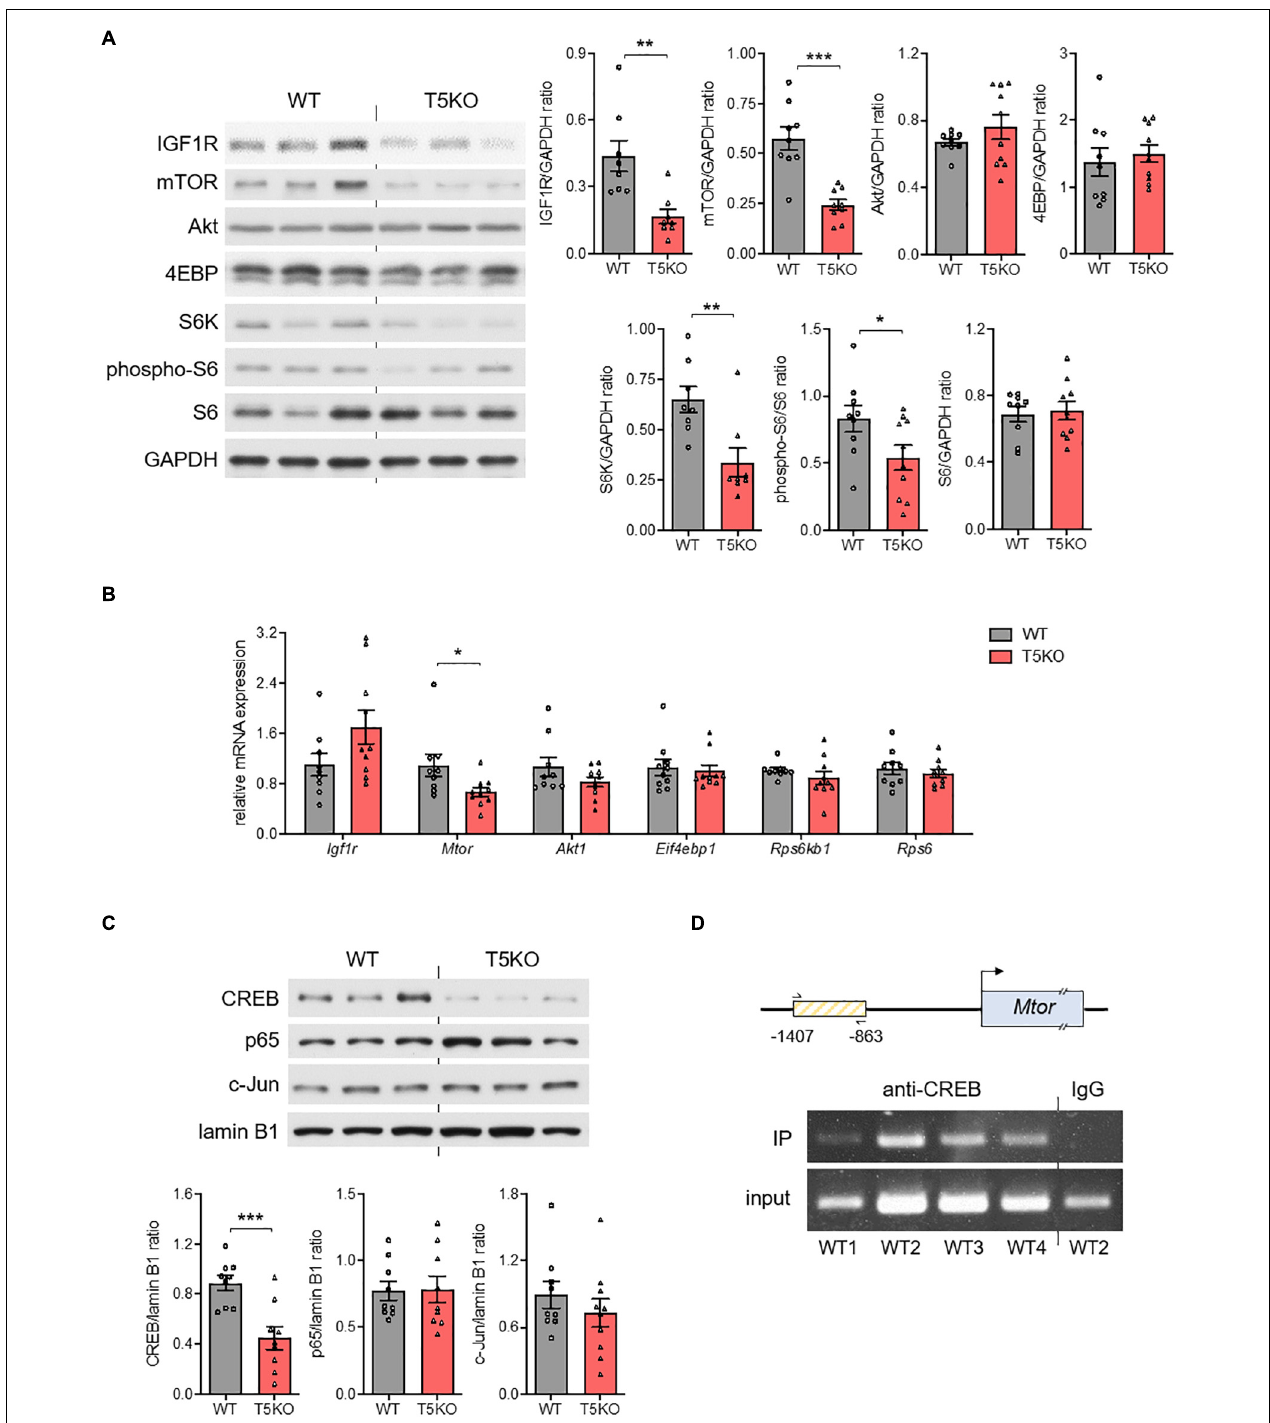
FIGURE 4 | Placental mTOR pathway was regulated by TLR5. (A–C) Conceptuses were isolated from pregnant wild type (WT) and TLR5-knockout (T5KO) mice at day 9.5 of pregnancy ( n = 8–10 litters, one randomly picked conceptus from each litter). The (A) protein and (B) mRNA expressions of IGF1R, mTOR, Akt, 4EBP, S6K, phospho-S6 and S6 were determined with GAPDH as loading control. (C) The nuclear abundances of CREB, c-Jun, and p65 were examined with lamin B1 as loading control. The densitometric analyses for A and C are shown on the right and lower panels, respectively. (D) Chromatin immunoprecipitation (IP) with anti-CREB antibody followed by PCR amplification using primers recognizing a segment of Mtor promoter [the box with yellow lines; contains the putative CREB binding site(s)] was performed with WT conceptus ( n = 4 litters, one randomly picked conceptus from each litter). Representative images are shown. Data are represented as mean ± SEM. The differences between genotypes were determined by two-tailed Student’s t -test. * P < 0.05, ** P < 0.01, *** P < 0.001.